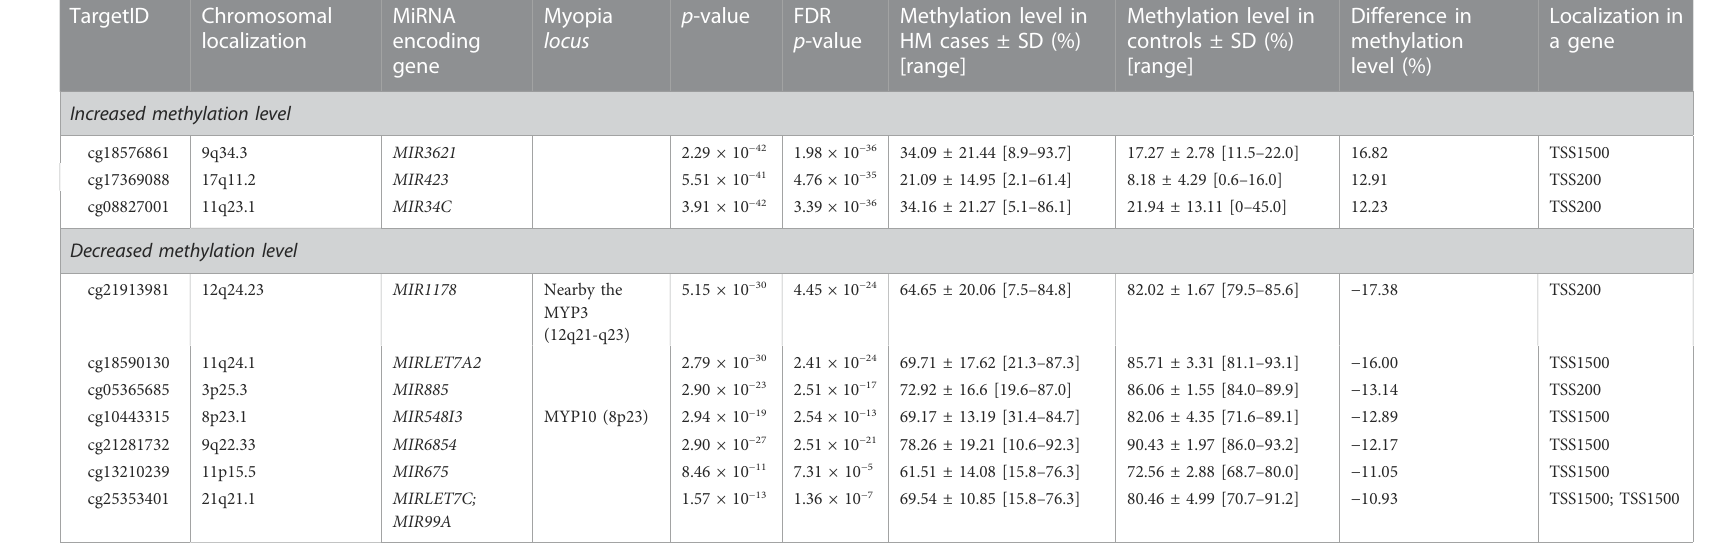
Localization in Methylation level in Difference in a gene controls ± SD (%) methylation level (%) [range]